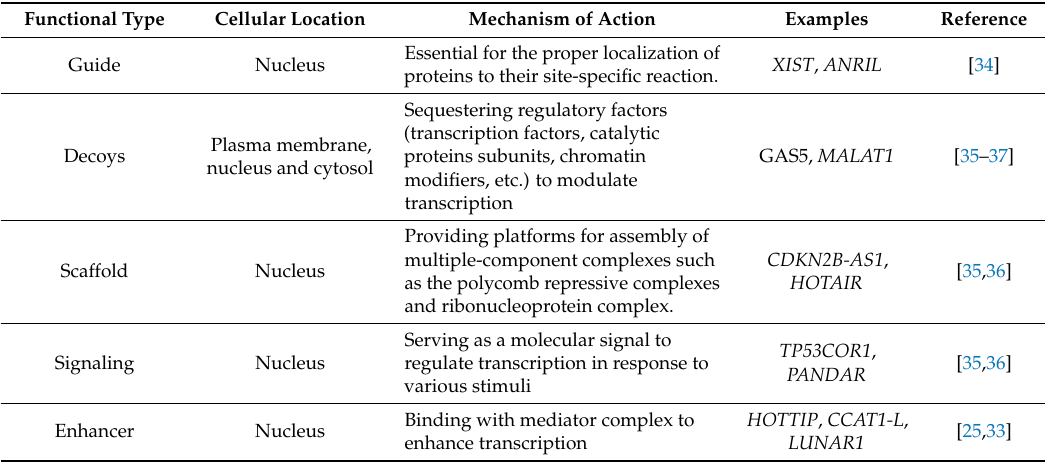
Table 1. Classification of lncRNAs according to their